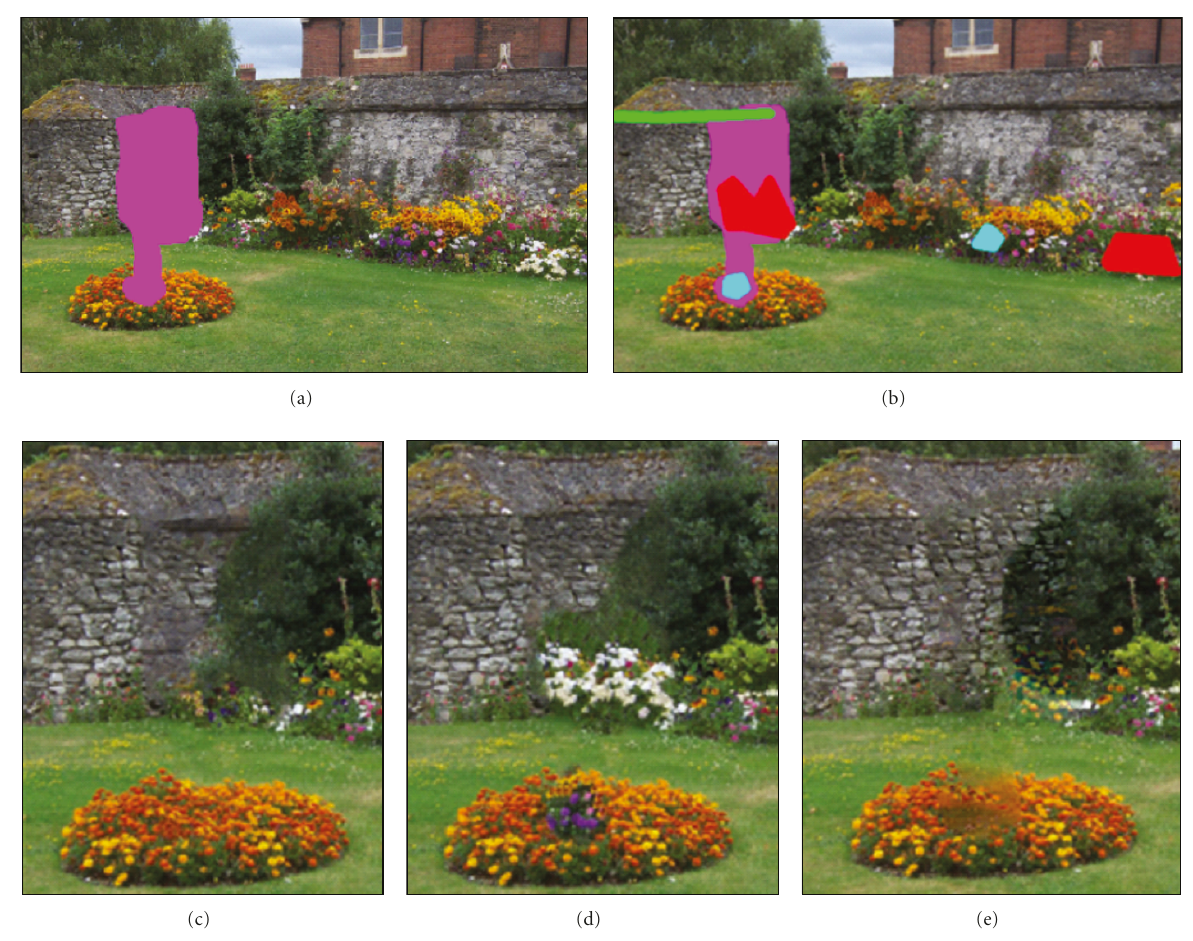
Figure 15: A given image for completing an artificially degraded region (a), the mask image with the user’s guidance (b), close-ups of the method in [16] (c), the method employing the user’s guidance in [16] (d), and the proposed method